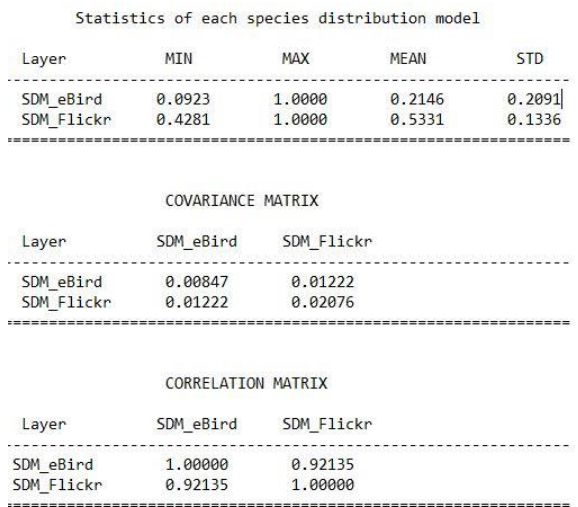
Figure 8: Species distribution maps and the models’ performances generated using Maxent for Common Kingfisher using the datasets of eBird (top), and Flickr (down) Table 1: Statistical comparison of the species distribution maps generated using eBird and Flickr